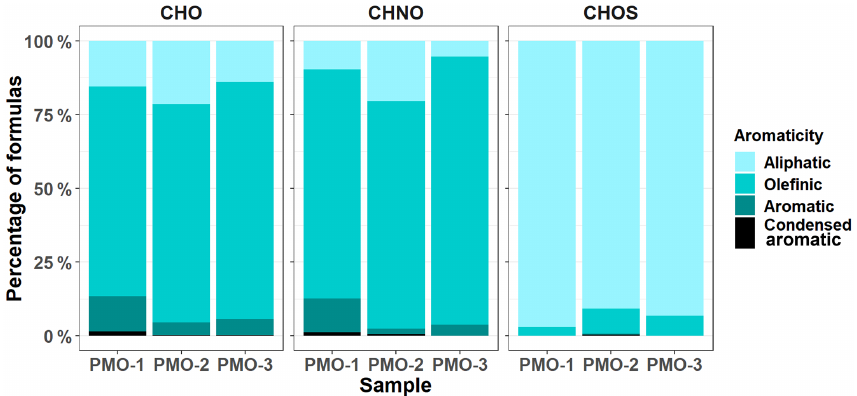
Figure 5. Normalized bar charts for the aromaticity of the three PMO samples, calculated using the Koch and Dittmar (2006, 2016) modified aromaticity index (AI mod